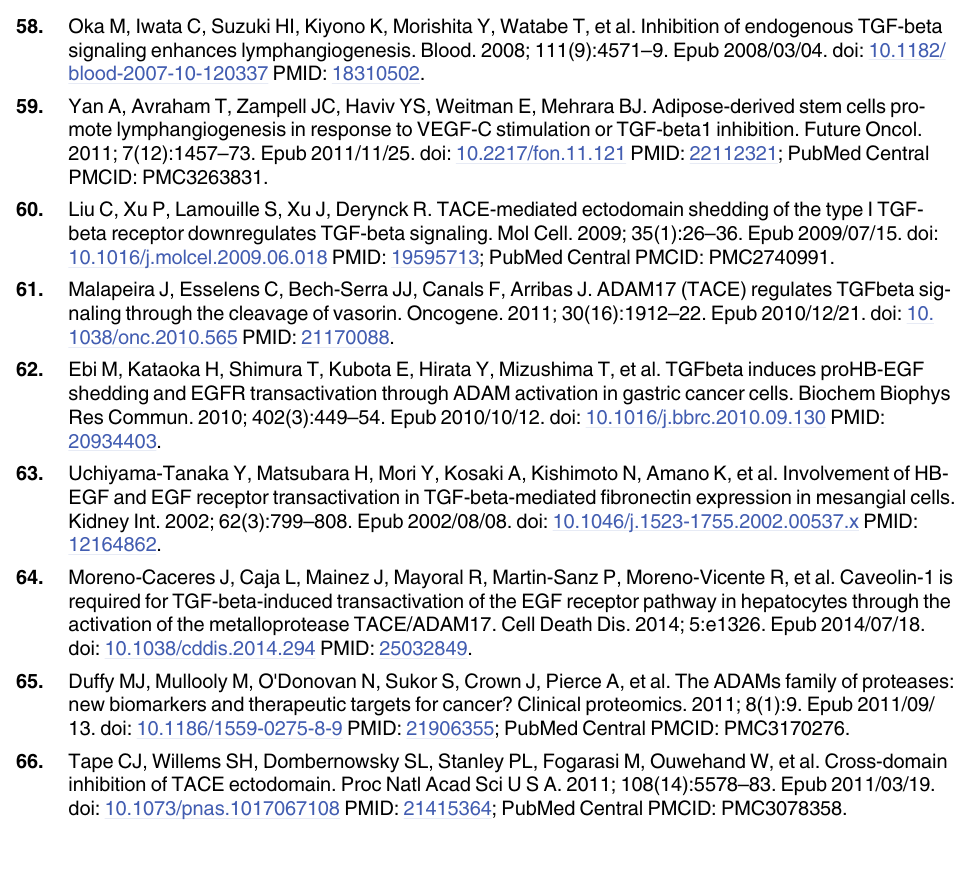
PLOS ONE | DOI:10.1371/journal.pone.0132661 July 15,